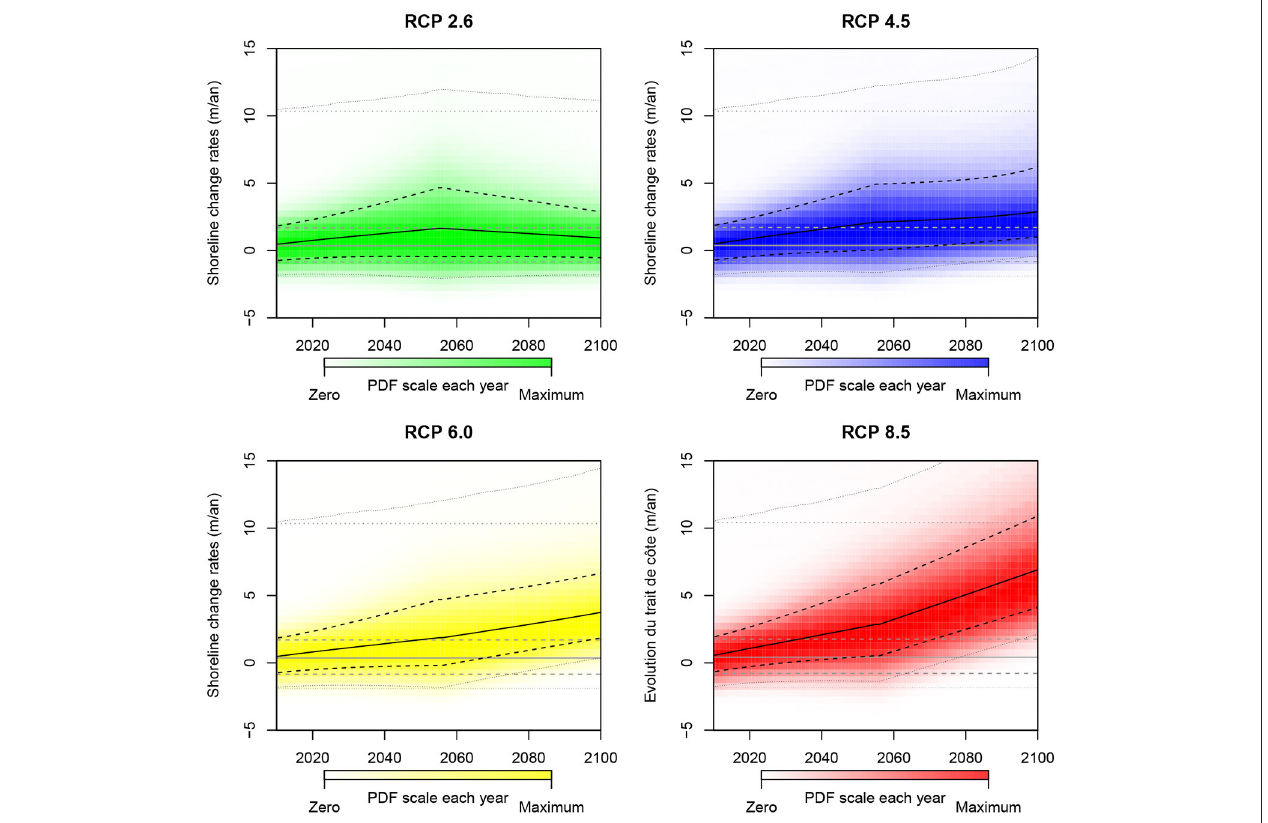
FIGURE 4 | Shoreline change rate projections for the 21st century for high-energy sandy coasts with no impacts of man-made infrastructures and for different IPCC climate change scenarios. The same results are obtained for low-energy beaches with groins (see values of the contributions of longshore processes to the sedimentary budget in Table 2 ). The meaning of gray and black lines is the same as in Figure 3